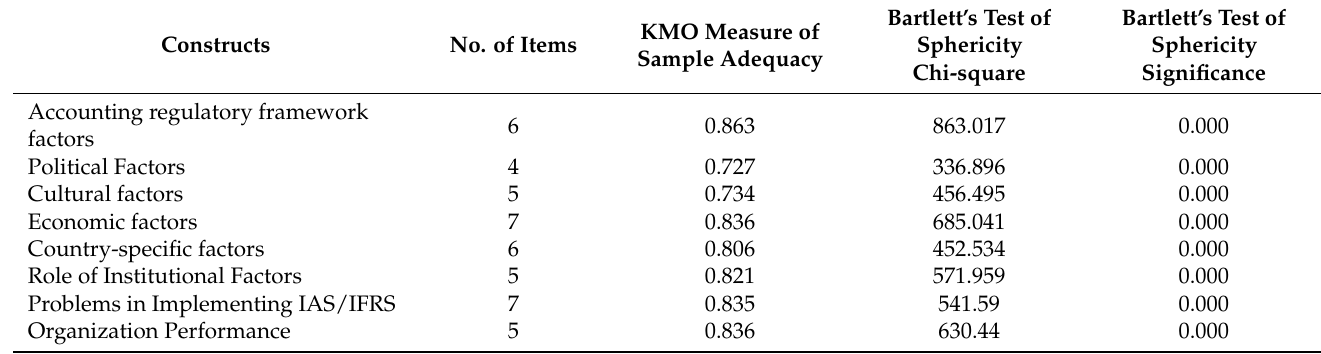
Table 3. KMO and Bartlett’s